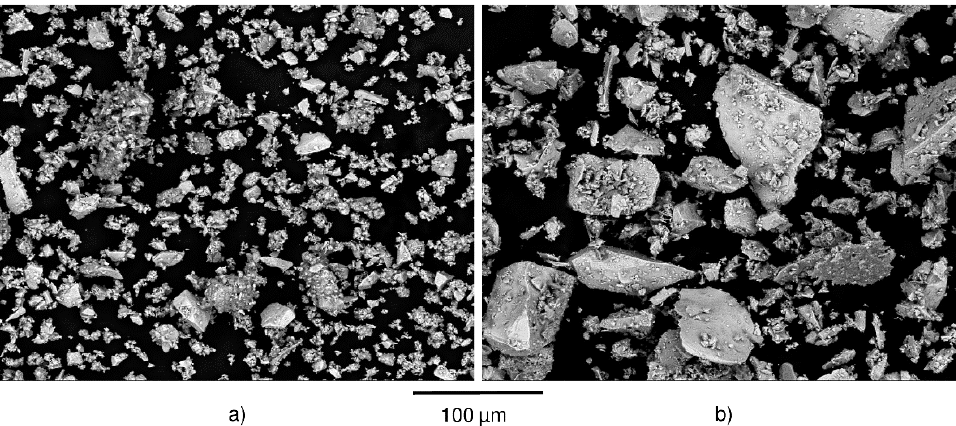
Figure 1. SEM image (secondary electron signal × 800) of ( a ) the fine fraction of pyrite and ( b ) the coarse fraction of pyrite .